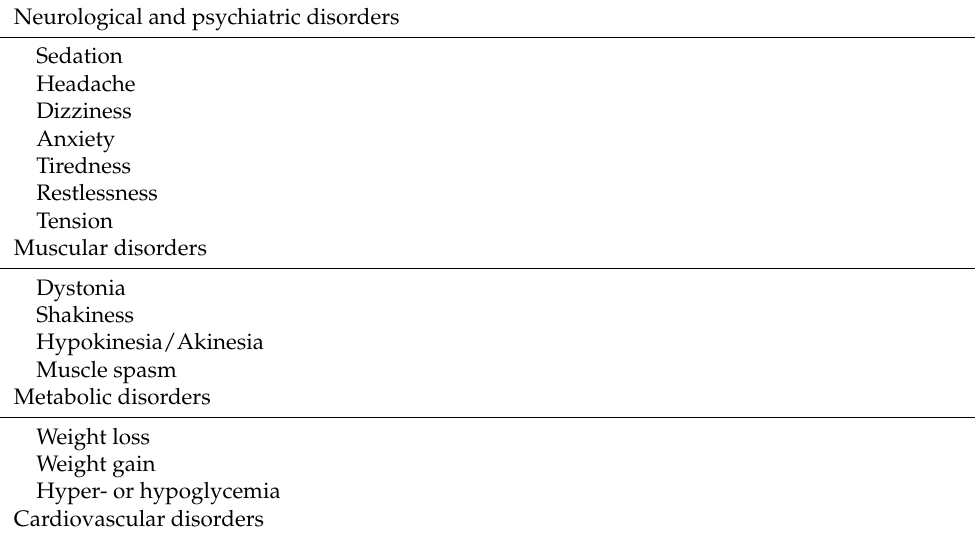
Table A2. List of adverse drug reactions that might have led to a phenotypic